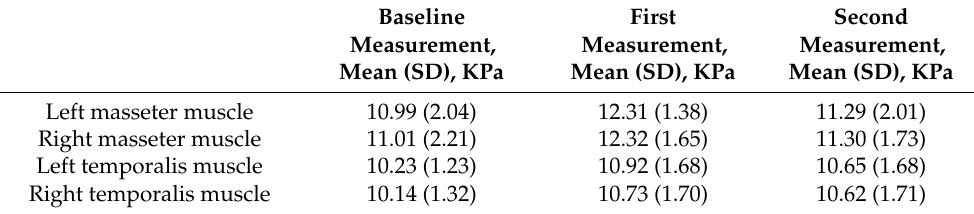
Table 1. Values of stiffness of the masseter and temporalis